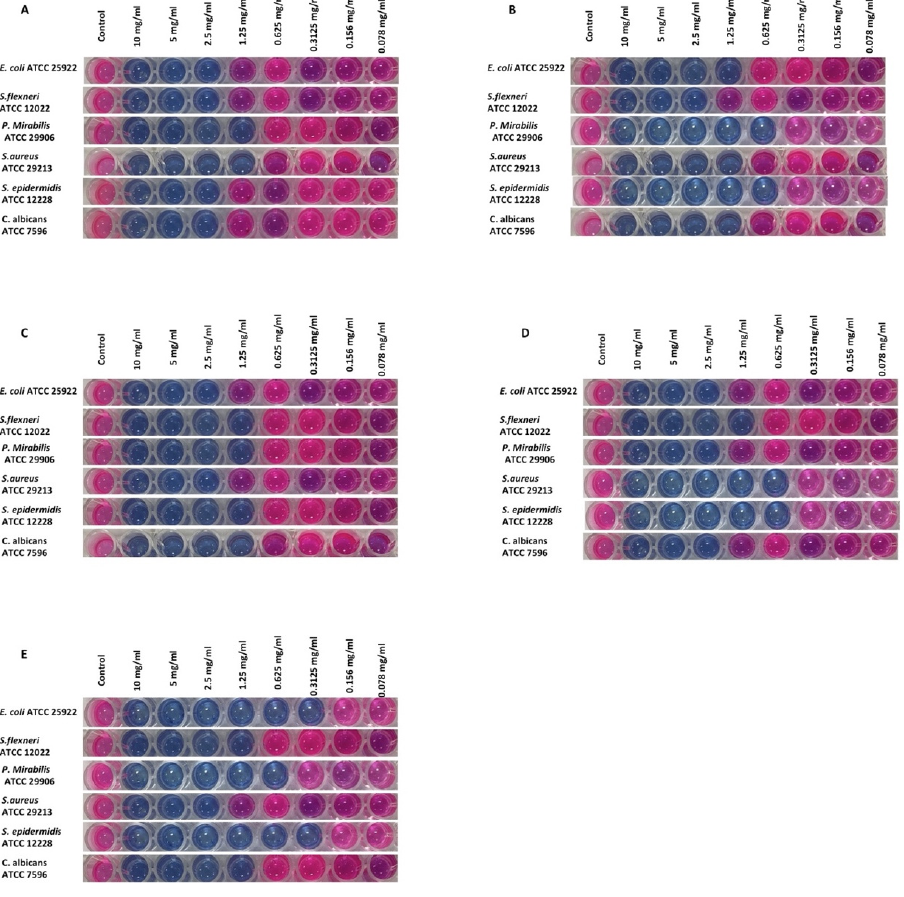
All isolated 1 – 6 flavonoids, depending on their potential activity, were subjected to docking with 2HCK (Haematopoietic cell kinase) and 5D6P (bacterial Gyrase B) to evalu- ate their binding interactions and effectiveness for antioxidant activity and antimicrobial activity, respectively. To visualize the interaction of ligands with macromolecules, .log (result) files were converted to .pdb file through pymol and were loaded to the Biovia Discovery Studio Visualizer (BDSV) to explore the binding design. Molecular docking was done with the objective to enhance our understanding of the receptor’s and ligand’s molecular interaction. The functions of proteins excessively depend upon a set of signifi- cant amino acid residues (Active sites) involved in interactions with the ligands. The residues of Kinase 2CHK, including Val281, Met341, Leu393, Thr338, Gly344, Ala403, Leu273, Asp404, and Ala293, are regarded as residues of the active site and are associated with the ligand–receptor interaction. The estimated docking score for 1–6 was in the order of − 6.2, − 6.0, − 8.5, − 6.0, − 8.5, and − 9.2 Kcal/mol, respectively. The ligand inter- actions of compounds 1 – 6 have been presented in Figure 5.